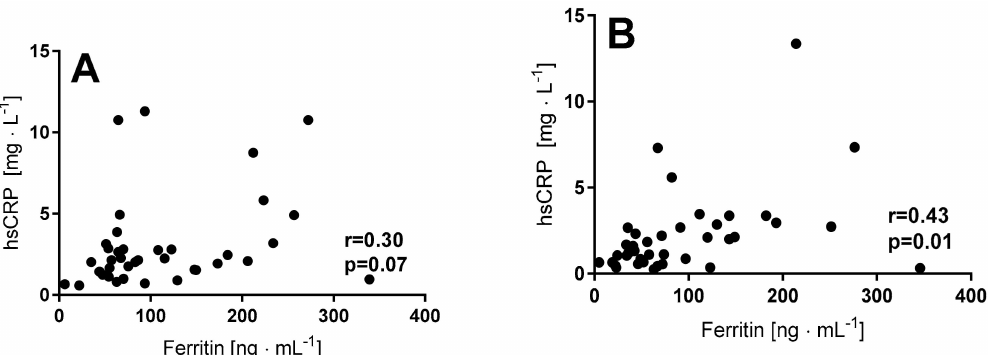
Figure 5. Correlation between ferritin and hsCRP at the baseline and in response to 12 weeks of Nordic Walking training in elderly women in a group with a baseline homocysteine < 10 µ mol · L − 1 ], ( A ) baseline, ( B ) after 12 weeks of